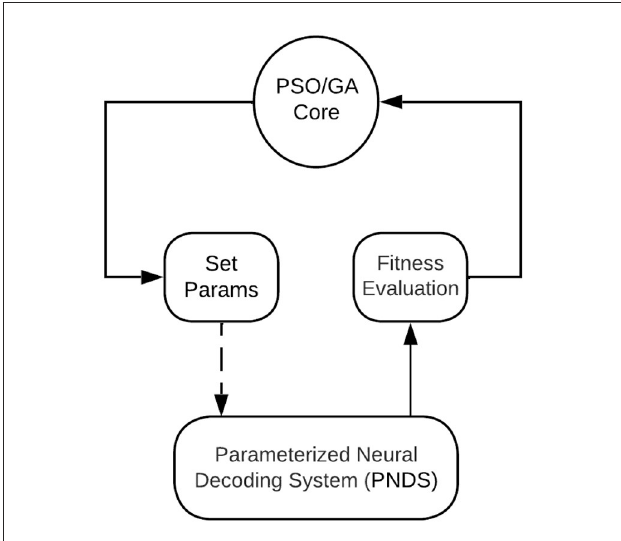
FIGURE1 An illustration of the overall architecture of the NEDECO platform. The PSO/GA Core means the actor could be either PSO Core actor or GA Core